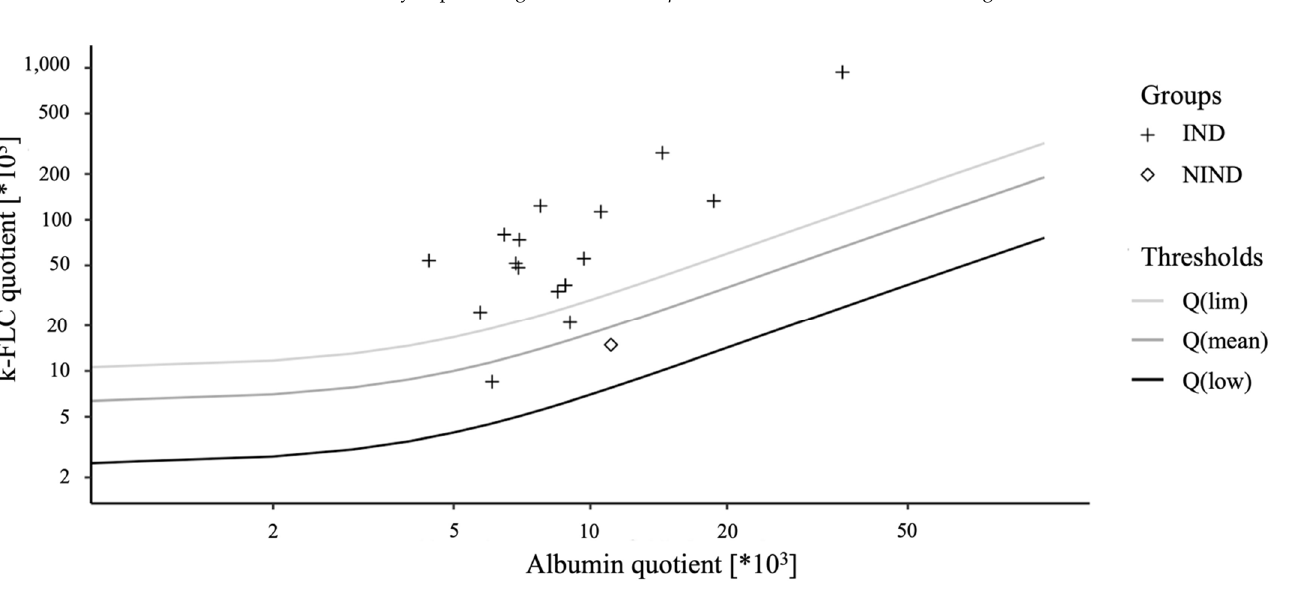
Figure 1. Data of the cohort in a double logarithmic kappa free light chains (k-FLC) Reibergram. Data points of the k-FLC measurement results plotted on a double logarithmic scale, corresponding to the Reibergram. Q(lim) represents the upper discrimination line, Q(mean) the middle and Q(low) the lower. IND: inflammatory neurological disease; NIND: non-inflammatory neurological disease.